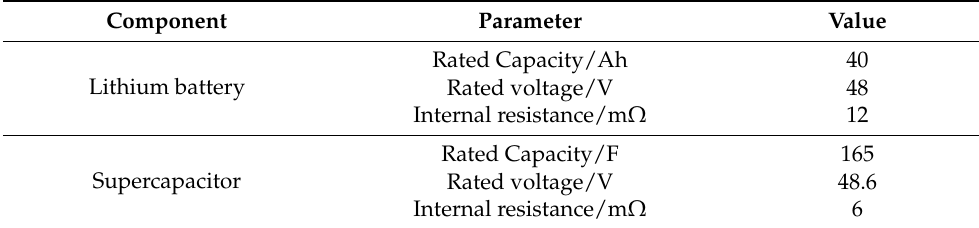
Table 1. System parameter values of the main components.